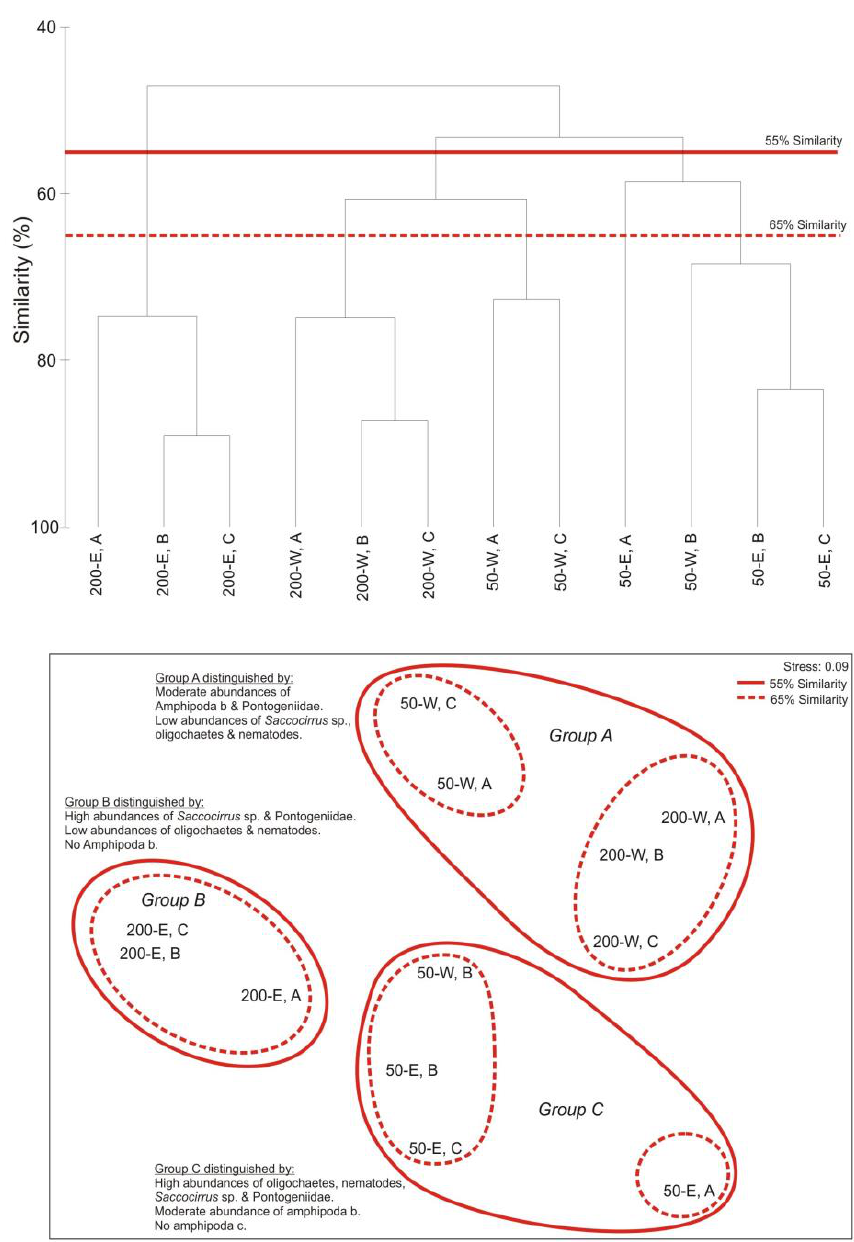
Figure 5. Cluster analysis and non-metric multi-dimensional scaling (nMDS) of intertidal infauna sampled from beach sites near the wastewater outfall. Samples linked at lower levels of similarity in the cluster analysis or closer together in the nMDS were faunally more similar. Data were 4th root transformed (2D stress = 0.09) and groups were formed based on 55% and 65% levels of similarity.